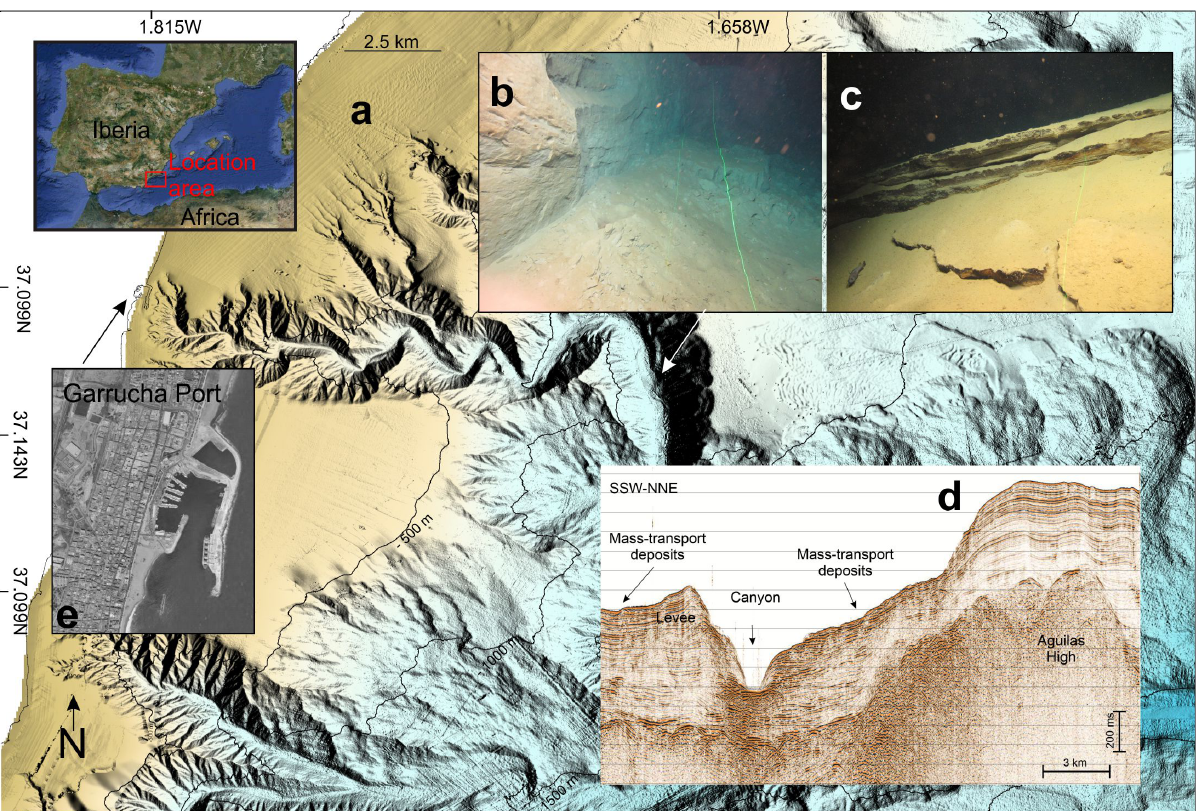
Figure 10. Example of multiple geological hazards in the Garrucha Canyon, SW Mediterranean: ( a ) Bathymetric map displaying a canyon head affected by intense gullying of its two main tributaries; ( b , c ) ROV (remotely operated vehicle) images displaying slope failures affecting the canyon walls; ( d ) seismic profile illustrating the occurrence of mass-transport processes that contribute to the erosion of the canyon walls; ( e ) photograph of the Garrucha port, which is located at the canyon head, where the sedimentary instability processes that contribute to canyon-head retrogradation affect its pier.